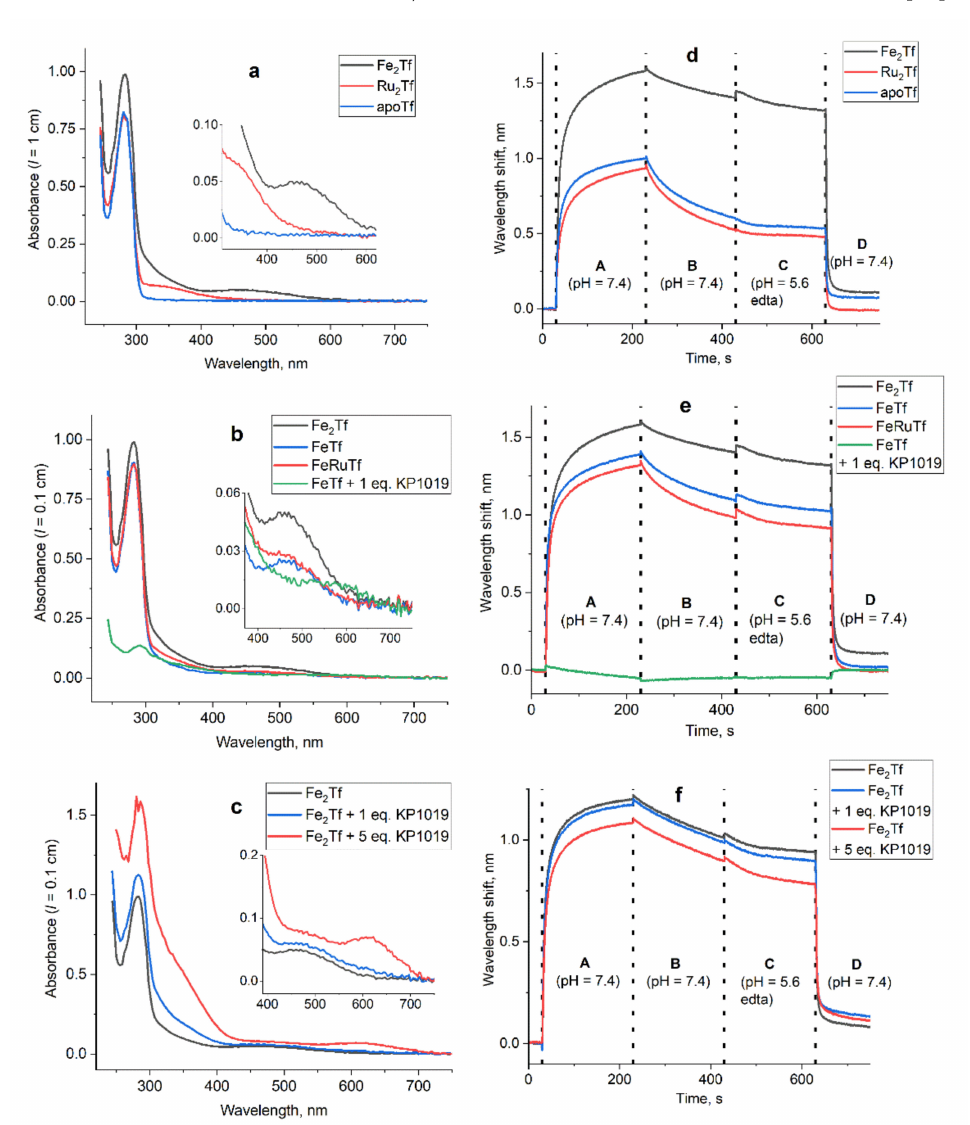
Figure 1. Representative UV-vis spectra ( a – c ) and the corresponding BLI curves ( d – f ) of Fe(III)–Ru(III)– Tf samples. Designations of the samples correspond to those used in Table 2. Tf concentrations were 0.10 mM for UV-vis spectra and 1.0 µ M for BLI experiments. The buffer used in UV-vis spectra and in the steps A, B and D of BLI experiments was 20 mM HEPES, 25 mM NaHCO 3 , 140 mM NaCl, pH 7.4. The buffer used in step C of BLI experiments was 100 mM MES, 300 mM NaCl, 4.0 mM Na 2 H 2 edta, pH 5.6 [24,30]. A summary of λ max , ε max (UV-vis) and K D (BLI) values is given in Table 2. All the data were collected at 295